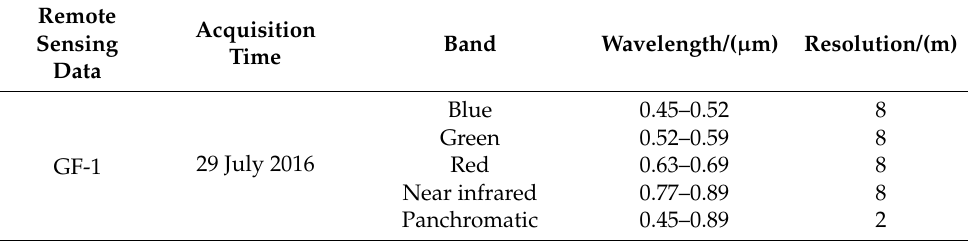
Table 1. The information of acquired GF-1 and Sentinel-2